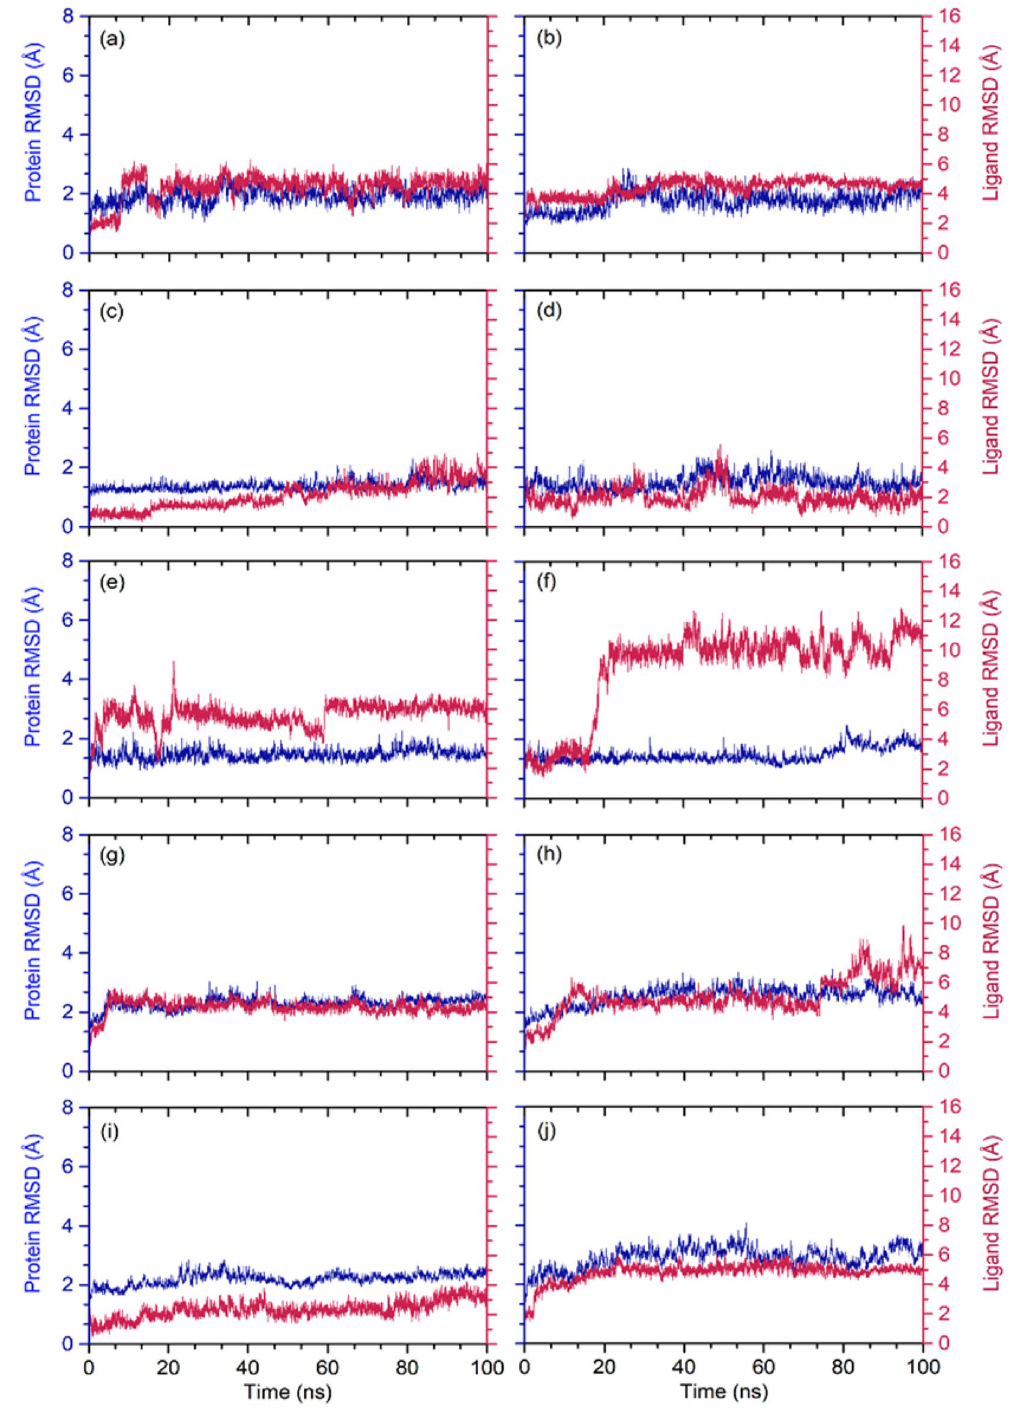
Figure 7. Calculated RMSD values for alpha carbon (Cα) atoms (blue curves) of SARS-CoV-2 proteins and docked ligands (red curves), viz. ( a ) SARS-CoV-2 M pro -Echinacin, ( b ) SARS-CoV-2 M pro -Echinacoside, ( c ) SARS-CoV-2 M pro -Cyanin, ( d ) SARS-CoV-2 M pro -Cyanidin 3-(6 ʺ -alonylglucoside), ( e ) SARS-CoV-2 Mpro-Quercetin-3-O-glucuronide, and ( f ) SARS-CoV-2 M pro - Proanthocyanidins, ( g ) SARS-CoV-2 RdRp- Echinacoside, ( h ) SARS-CoV-2 RdRp-Rutin, ( i ) SARS-CoV-2 RdRp-Kaempferol-3-O-rutinoside, and ( j ) SARS- CoV-2 RdRp-Quercetin-3-O-xyloside, were plotted with respect to 100 ns simulation